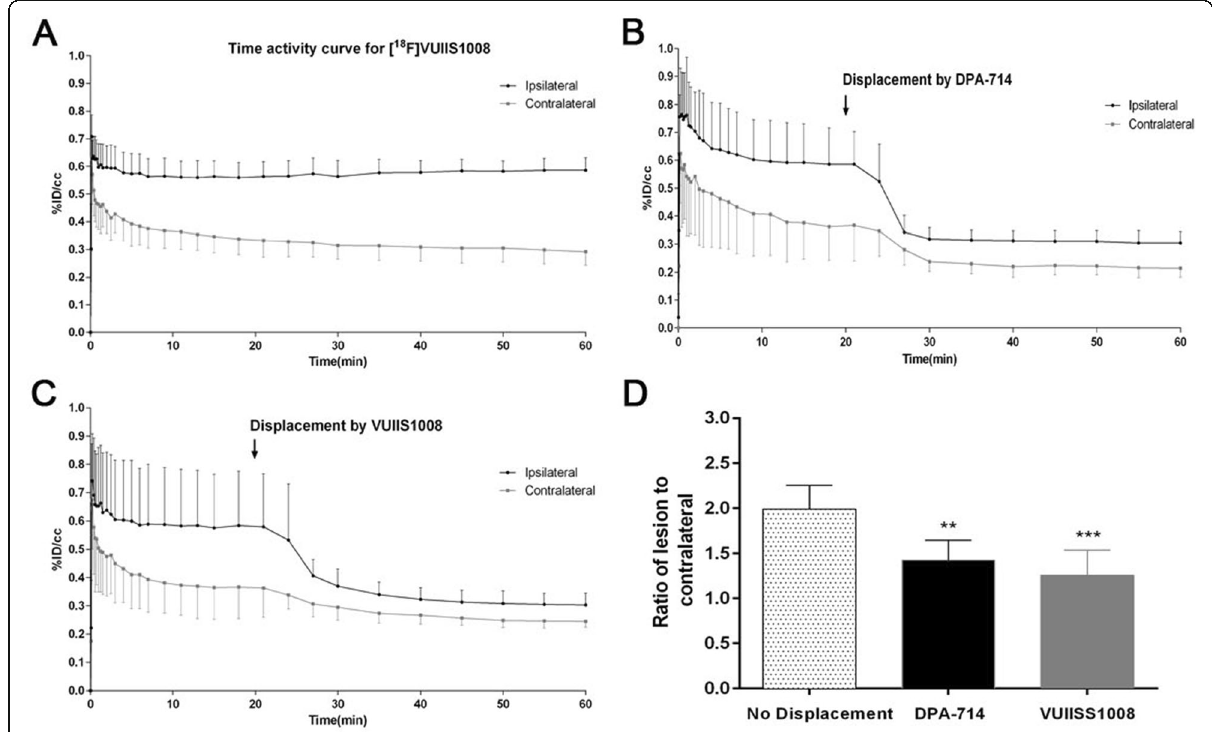
Fig. 5 Time-activity curves for [ 18 F] VUIIS1008 and displacements by an excess of 1 mg/Kg of either DPA-714 or VUIIS1008 at day 7 after ischemia onset. The activity curve of the VOI placed on the ipsilateral (lesion) or on the contralateral hemisphere of rats injected with [ 18 F] VUIIS1008 ( n =8) ( a ) are shown. Displacement experiments: [ 18 F] VUIIS1008 followed by DPA-714 ( n =5) ( b ) and [ 18 F] VUIIS1008 followed by VUIIS1008 ( n =6) ( c ). d Corresponding ratios of the lesion to the contralateral brain hemispheres of non-displaced and displacement experiments at 60 min. Data are expressed as %ID/cm 3 ratios of the lesion to the contralateral brain hemisphere. Arrows indicate the time of displacement at 20 min after radiotracer